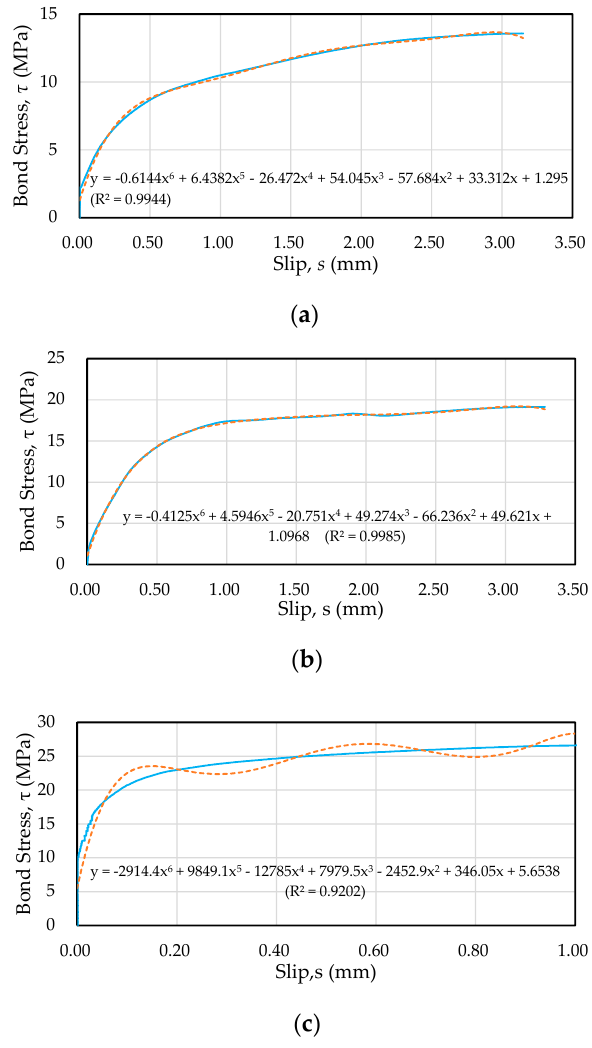
Figure 21. Comparison of the local bond stress–slip curve versus fitting curve for specimens with the #8 rebar: ( a ) C20, ( b ) C40, and ( c ) C60.